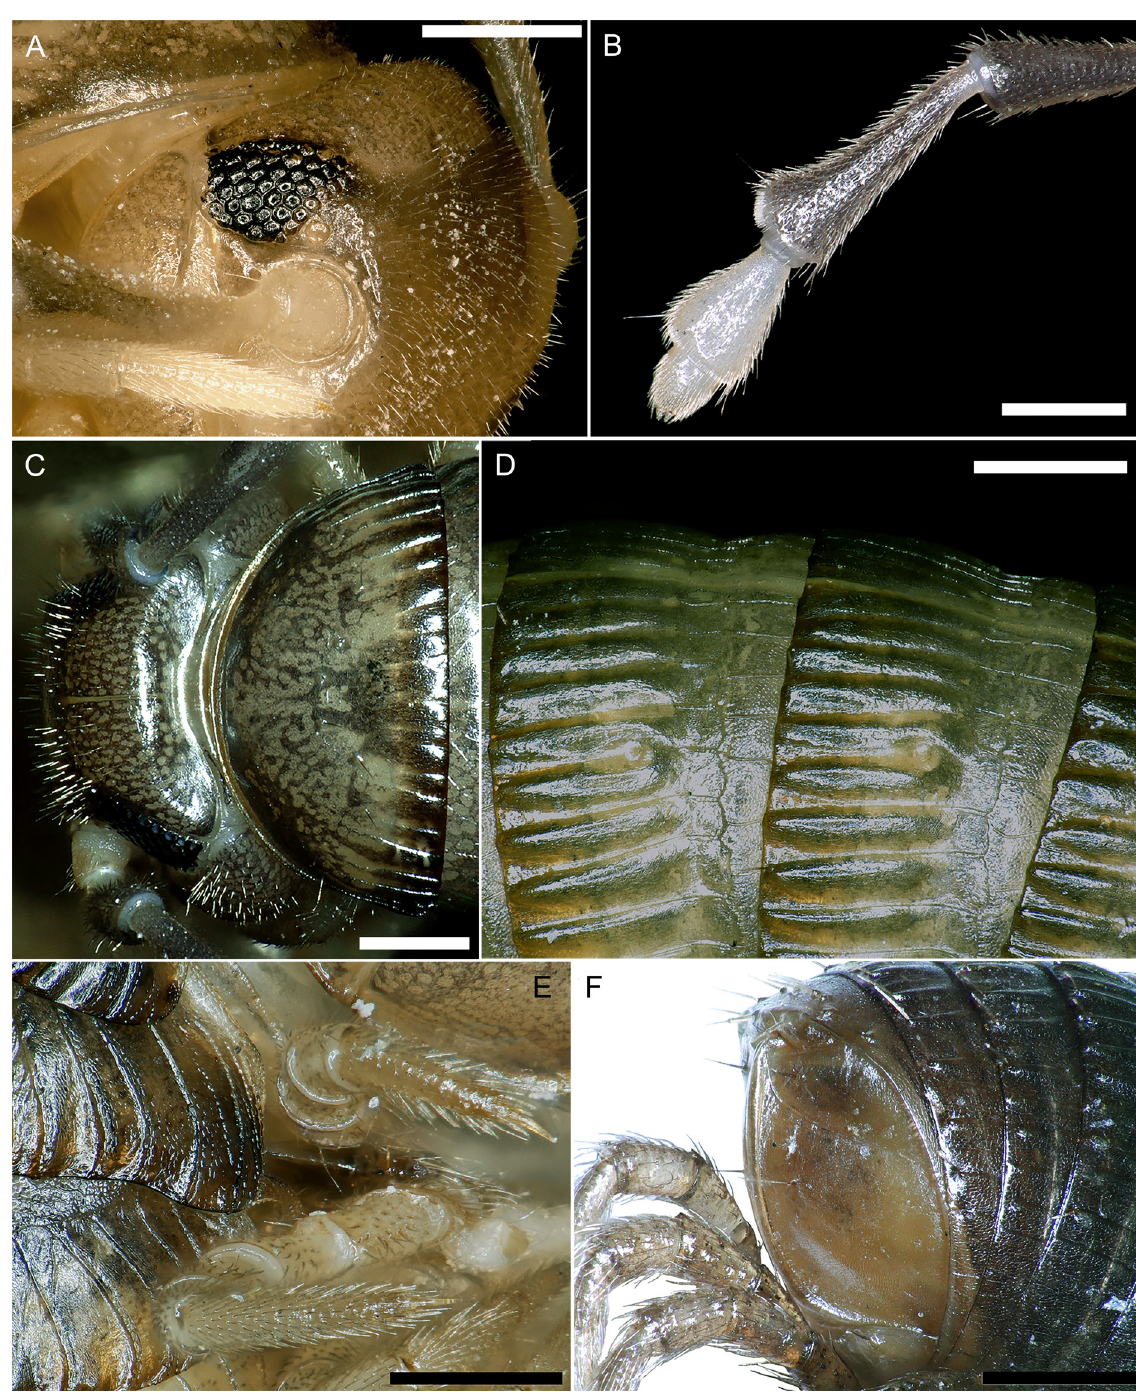
Fig. 3. Morphological details of Lusitanipus xanin sp. nov. A . Head of ♂ paratype (note: colour has faded after 13 years in ethanol) (MNCN 20.07/2071). B . Last antennomeres of ♀ paratype (MNCN 20.07/2070). C . Posterodorsal part of the head of ♀ paratype and collum in dorsal view (MNCN 20.07/2070). D . Dorsal part of pleurotergites 5 (only partially visible) to 7 in lateral view (MNCN 20.07/2070). E . Detail of ventral part of first rings of ♀ in lateral view, with posterior tip of collum and pleurotergite 2 visible, four first pair of legs (second reduced) and coxal sacs (MNCN 20.07/2070). F . Telson and last rings of ♀ paratype (MNCN 20.07/2070). Scale bars = 0.5